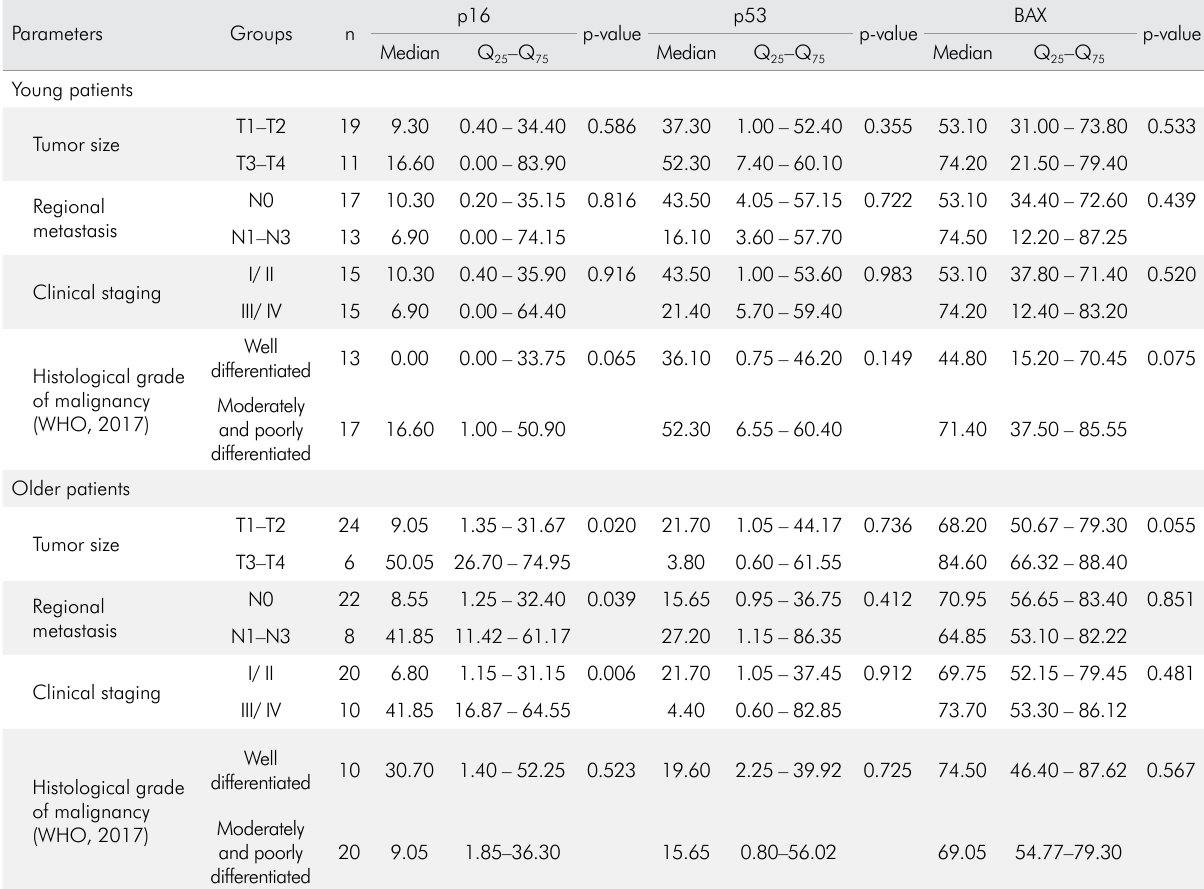
Table 2. Comparison of immunoexpression of p16, p53, and BAX in cases of OTSCC in young (≤4 5 years) and elderly (≥ 60 years) patients according to clinico-morphological